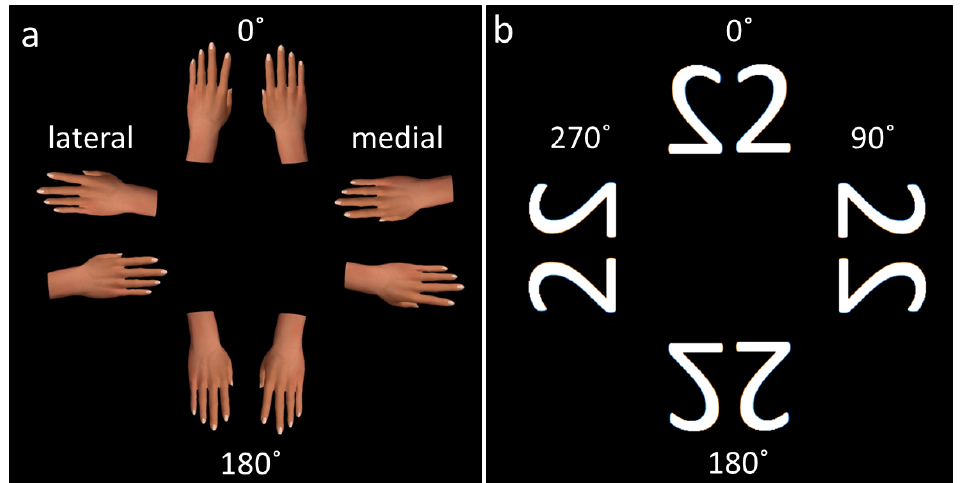
Figure 1. Stimuli used in the ( a ) MI task (courtesy of [34]) and ( b ) VI task at the different orientations. Hand images in the lateral orientation were regarded as stimuli with high biomechanical constraint and those in the medial orientation as low biomechanical constraint.